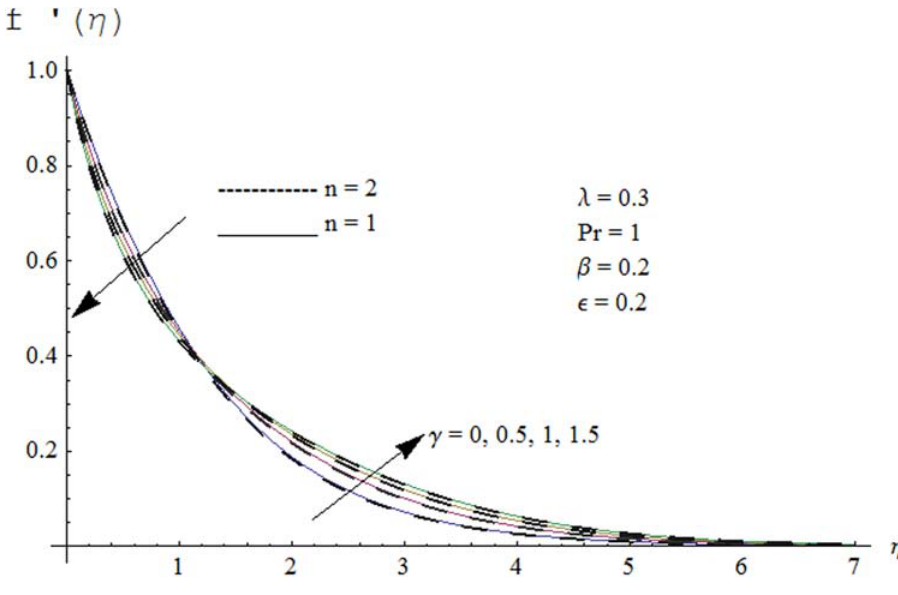
Fig 8. Effect of γ on velocity profile.